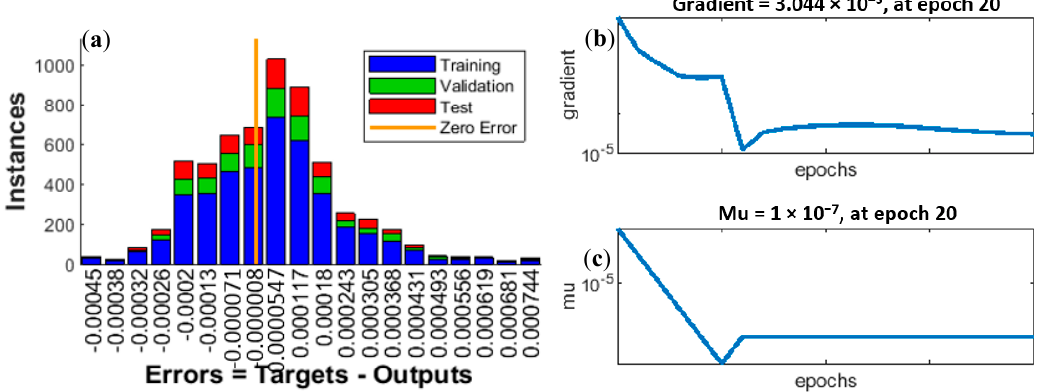
Figure 12. ( a ) Error histogram with 20 bins, ( b ) gradient curve, ( c ) Mu curve.